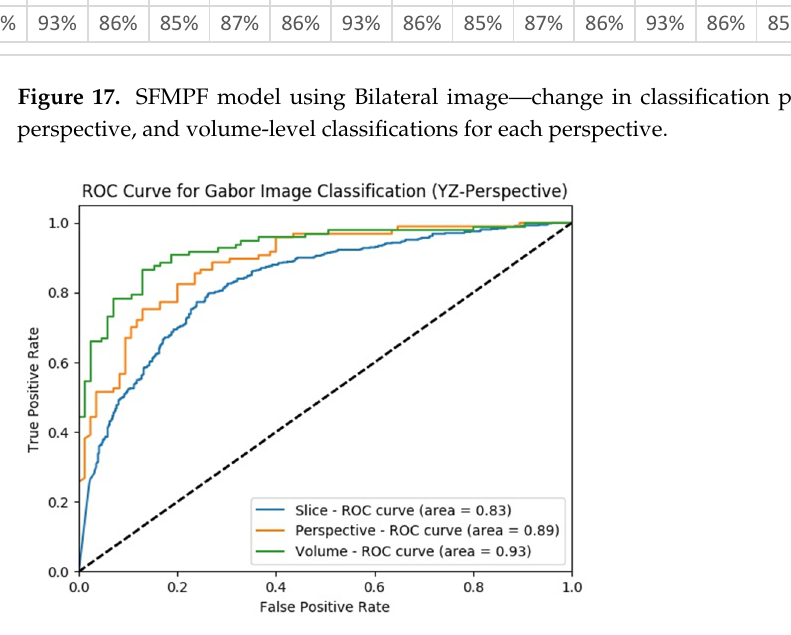
Figure 18. SFMPF model using Bilateral image—comparison of ROC curve for slice, perspective, and volume-level classifications for the slices from YZ-perspective.